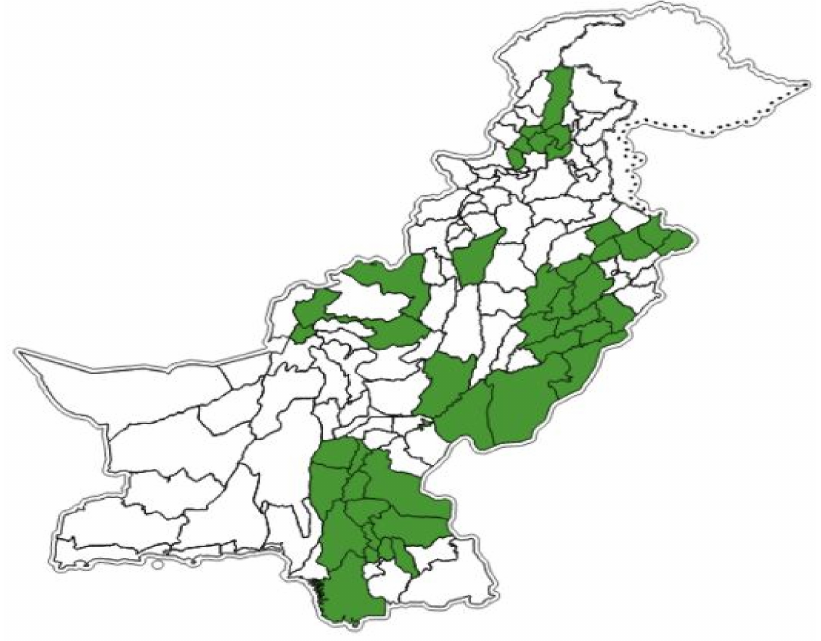
Figure 10. Distribution of Biomass for electricity generation